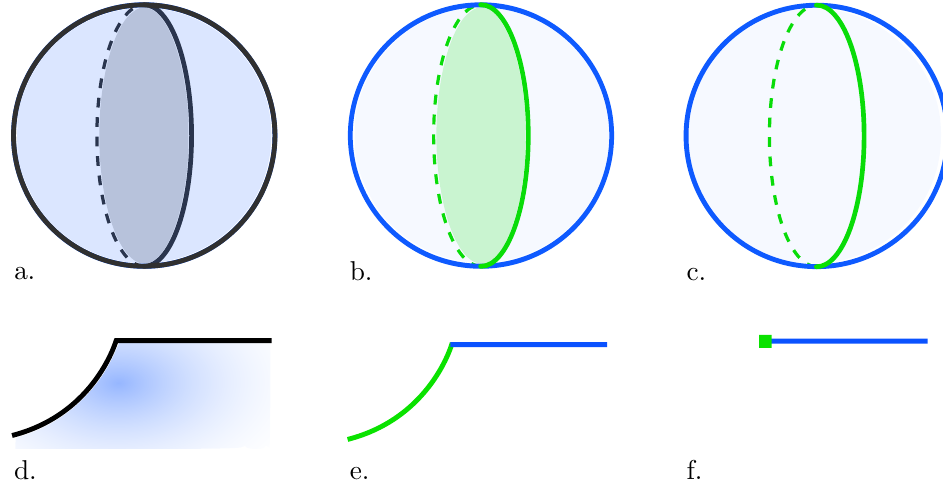
Figure 3 . This (cid:12)gure shows the relation between a time-slice in our construction and the holo- graphic setup of [22]. The top row illustrates three perspectives with which the system discussed here can be described, while the bottom row displays the analogous descriptions for the model in [22]. The comparison can be made more precise by performing a Z 2 orbifold quotient across the bulk brane/conformal defect in the top row. a. Bulk gravity perspective, with an asymptotically AdS d +1 space (shaded blue) which contains a co-dimension one Randall-Sundrum brane (shaded grey). b. Brane perspective, with dual CFT d on the asymptotic boundary geometry (blue) and also extending on the AdS d region (shaded green) where gravity is dynamical. c. Boundary perspective, with the holographic CFT d on S d (cid:0) 1 (blue) coupled to a codimension-one conformal defect (green). d. AdS 3 formulation with two boundary components: the (cid:13)at asymptotic boundary (straight black line) and a \Planck brane" (curved black line) with an AdS 2 geometry. e. The holographic CFT extends over a region with a (cid:12)xed metric (blue) and an AdS 2 region with JT gravity (green). f. The microscopic description as a two-dimensional BCFT (blue) coupled to a quantum mechanical system at its boundary